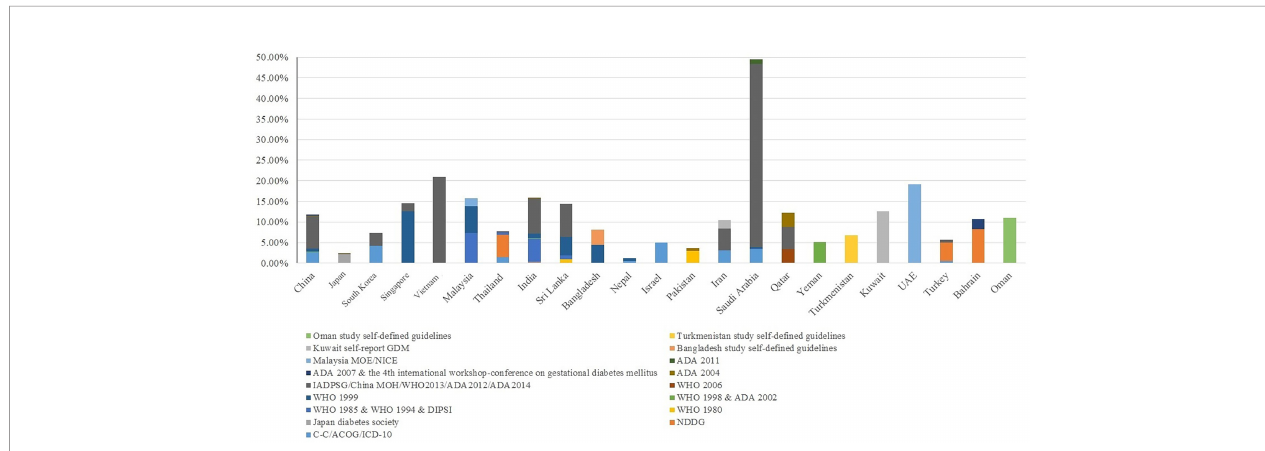
FIGURE 2 | Country-speci fi c prevalence of GDM in Asian studies. Due to the homogeneity of Chinese population residing in China, Taiwan and Hong Kong, we reported the country-speci fi c prevalence of these three regions as a whole.